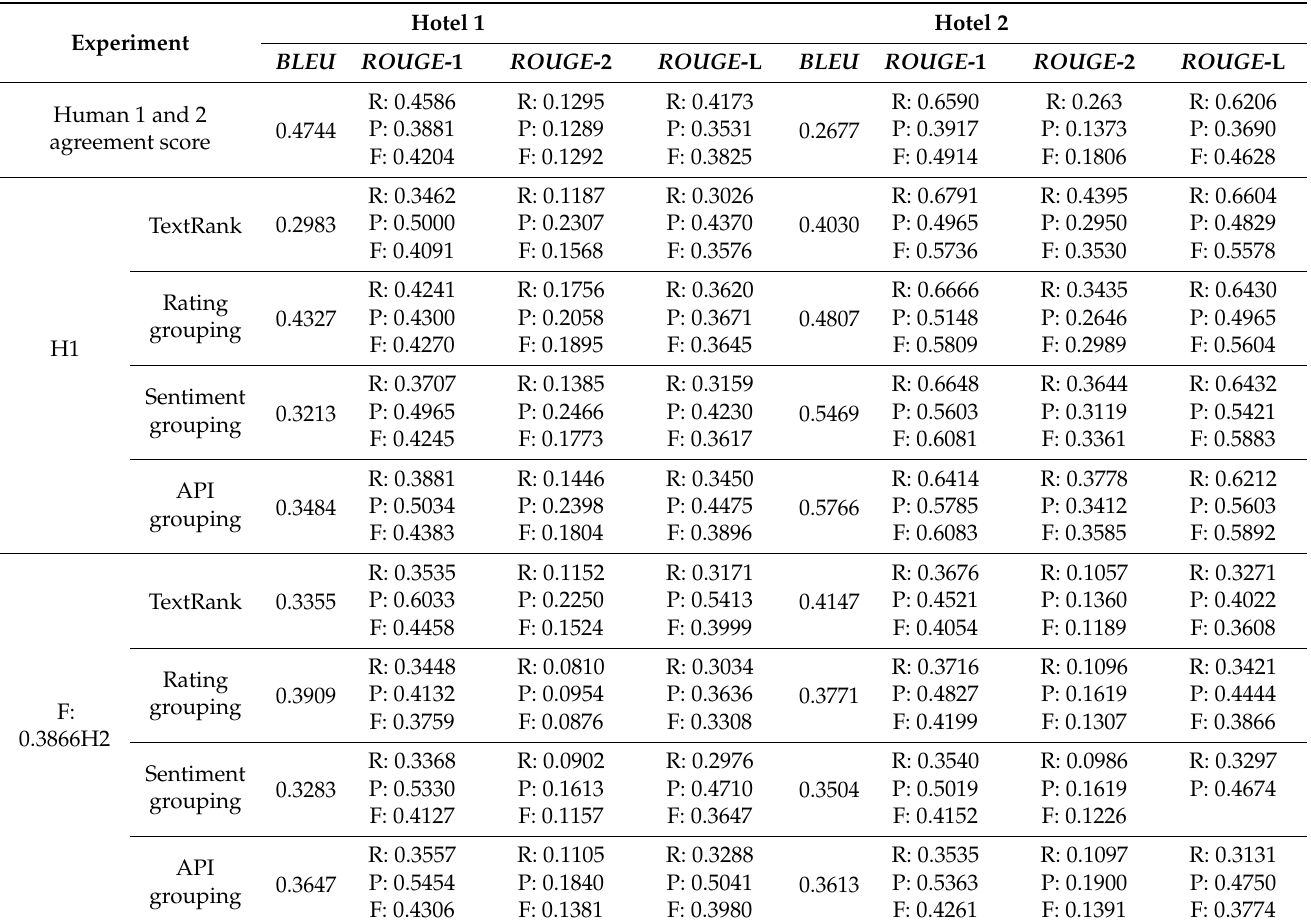
Table 8. Performance evaluation of summarizing both hotels’ reviews with TextRank, and the proposed method with three-class polarity grouping by the three suggested approaches: rating score, the DL-based sentiment, and using Mazajak API, against human-generated summaries 1 and 2 (H1 and